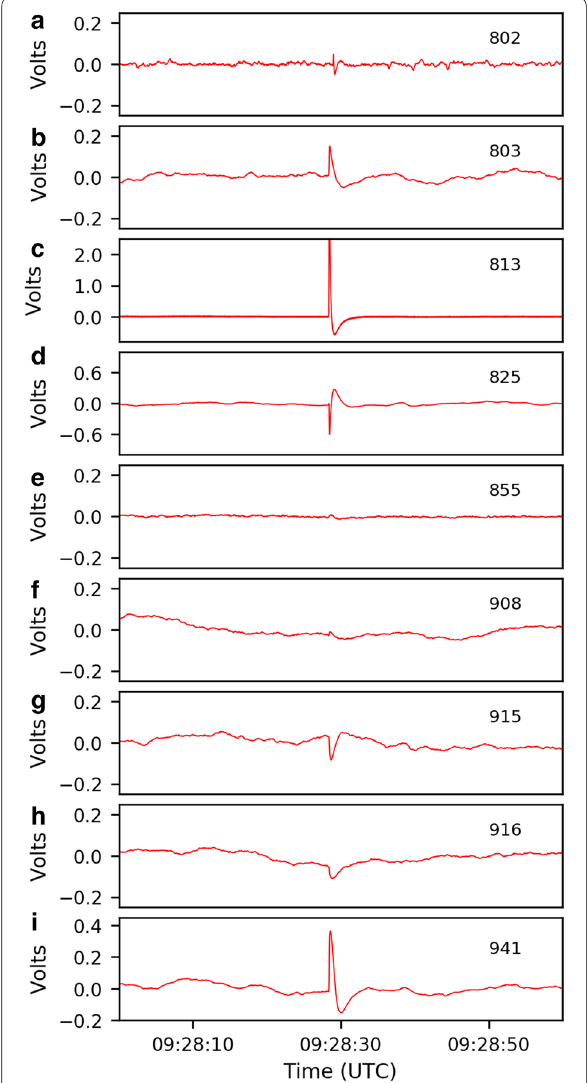
Fig. 11 Time series recorded in voltage at nine nearby Quake- Finder stations. The pulse shown in Fig. 10a was detected at all nine QuakeFinder stations at 09:28:30 UTC, April 25, 2014. a – i Each station is labeled by station ID 802, 803, 813, 825, 855, 908, 915, 916, and